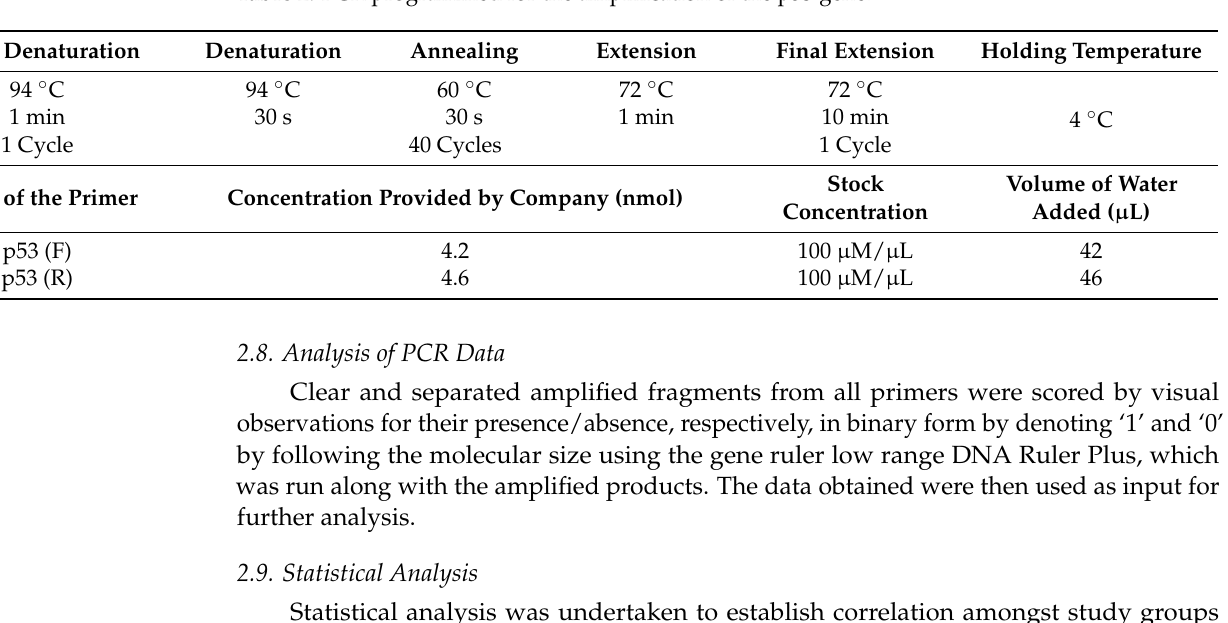
Table 2. PCR programmed for the amplification of the p53 gene.